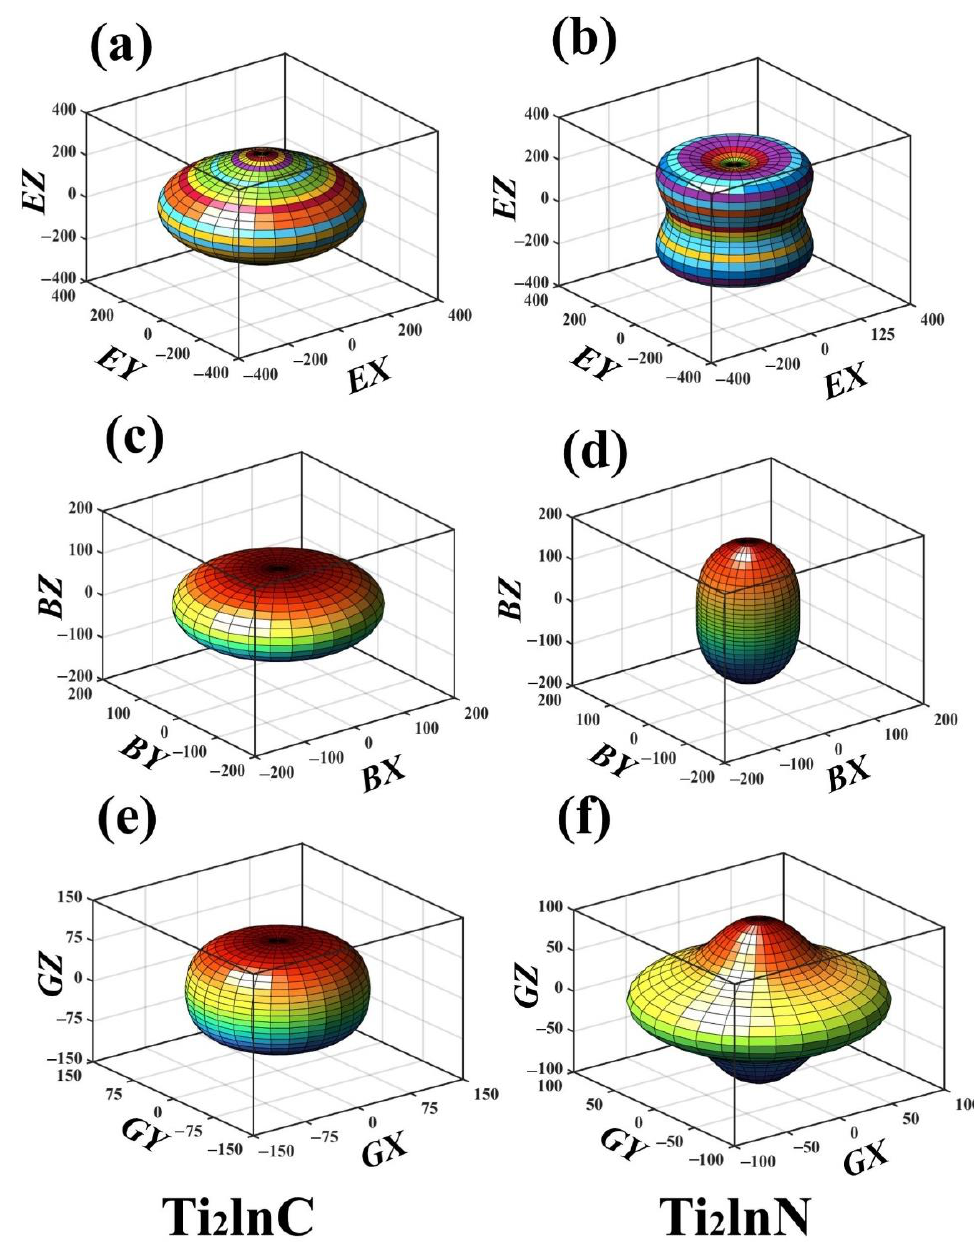
Figure 6. Three-dimensional surface constructions of E ( a , b ), B ( c , d ) and G ( e , f ) of M 2 InX (M = Ti, Zr and X = C, N) MAX phases. The unit is GPa.